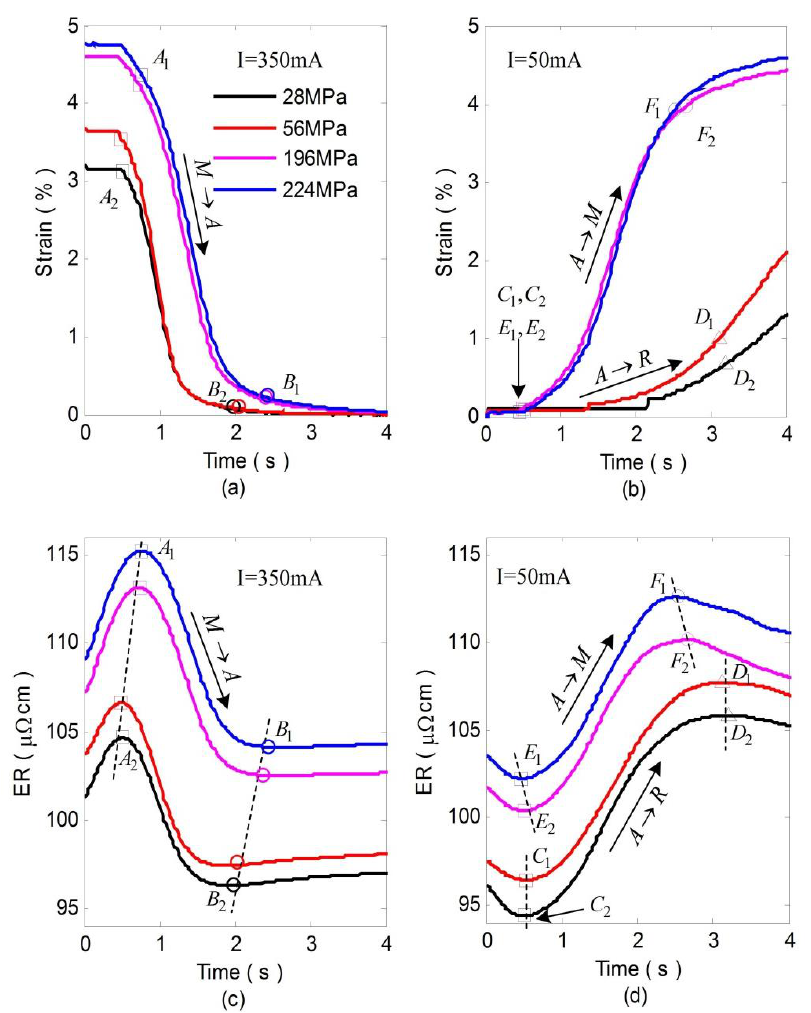
Figure 6. Experimental results of strain ( a , b ) and corresponding ER ( c , d ) changes of SMA wire during heating (I = 350 mA) and cooling (I = 50 mA) at various stresses.